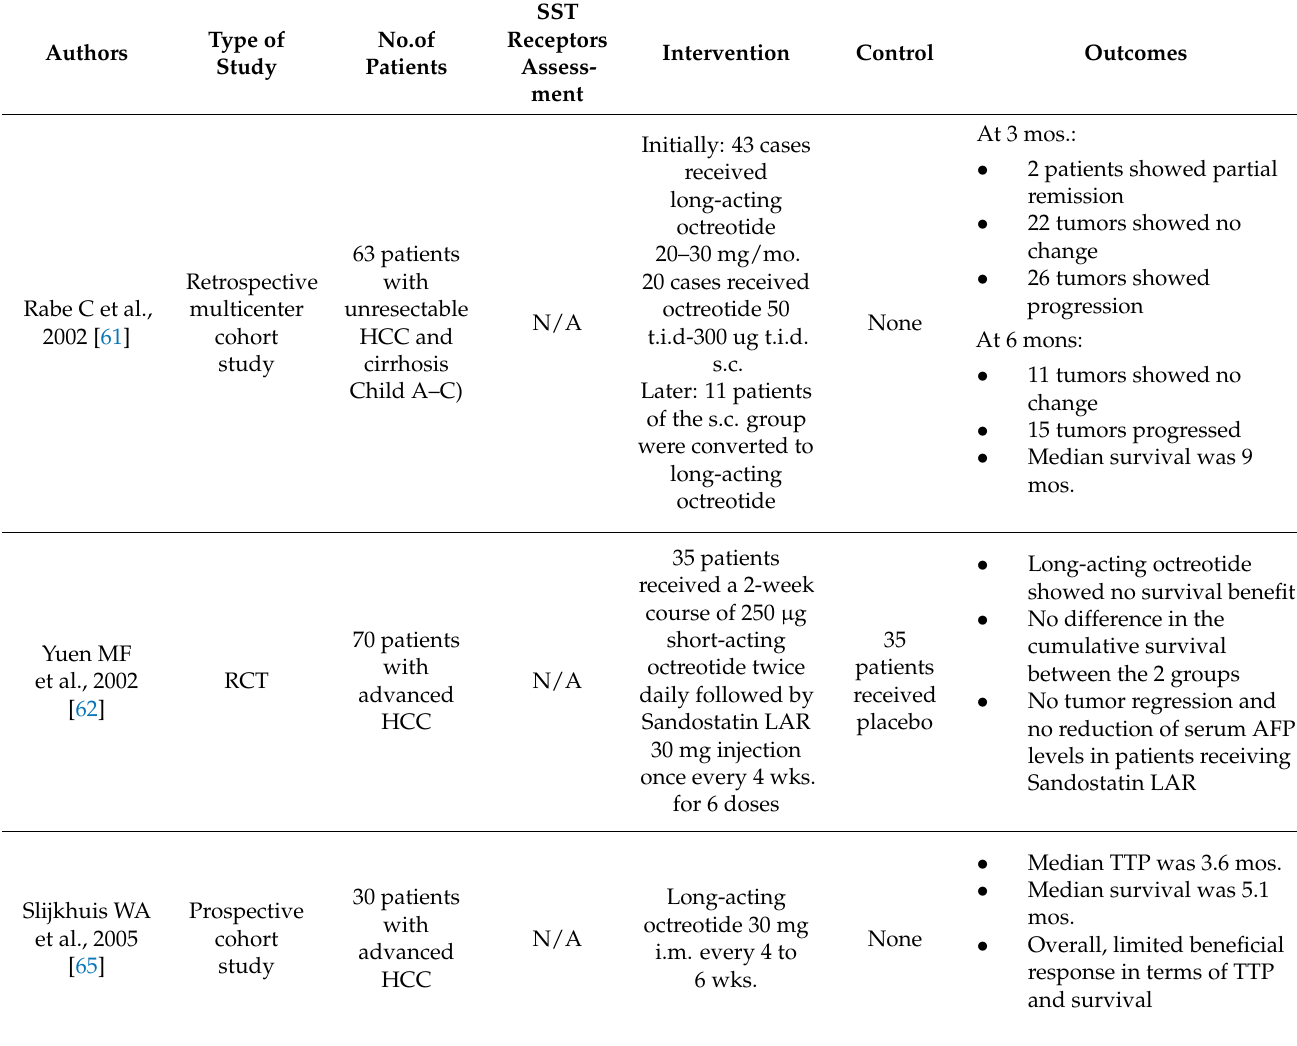
Table 2. Summary of the negative studies about the role of somatostatin analogues in the treatment of advanced HCC